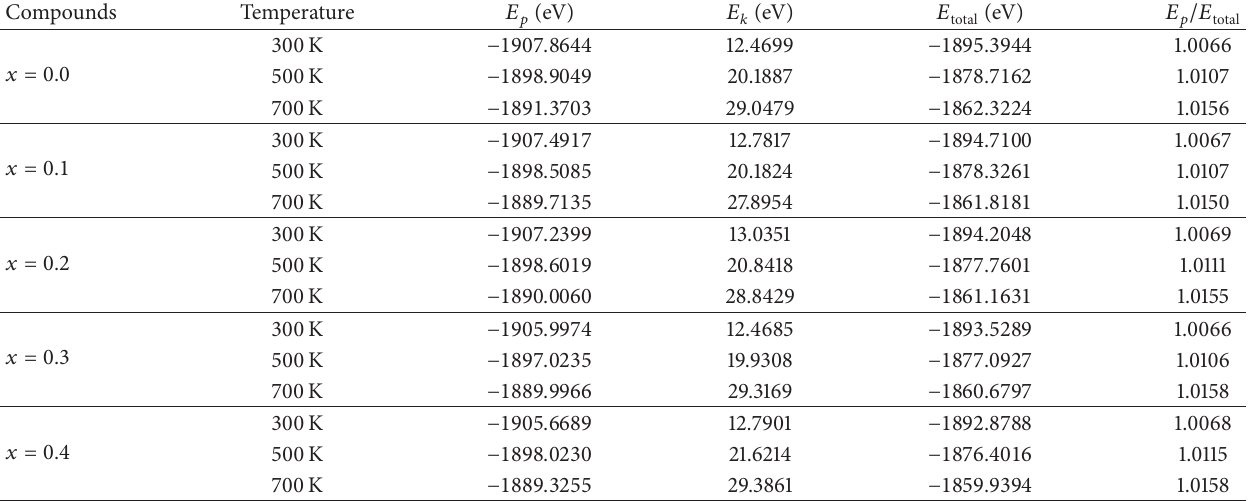
Fe 27.4−𝑥 Co 𝑥 V under different temperatures. 3 1.6